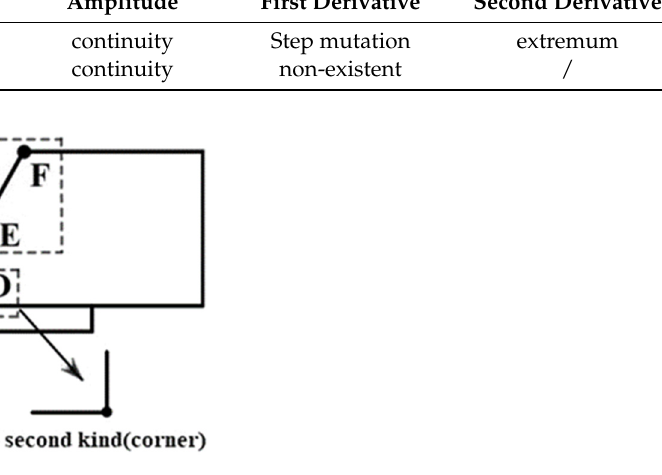
Figure 3. Classification of groove feature points.